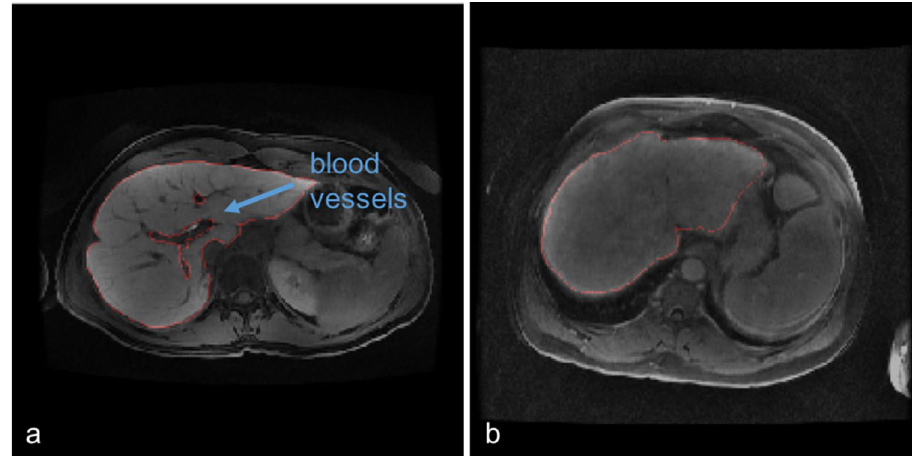
Figure 1. HBP MR images acquired at 20 min after the injection of hepatobiliary contrast agent and corresponding segmented liver regions (red line) ( a ) Adequate HBP: vessels are hypointense to background liver and clearly visible. ( b ) Suboptimal HBP: vessels are isointense to liver and difficult to identify.